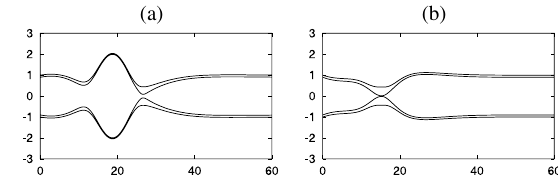
Fig. 4 Breakup profiles of the jet for di ff erent η when ρ = 0 . 001, σ = 1, ¯ b = 0 . 1 and ¯ u 1 = ¯ u 2 = 1, where Wb = 125 and ω = 0 . 04; (a) η = 0 . 1 at t = 19 . 63 and (b) η = − 0 . 1 at t = 16 .